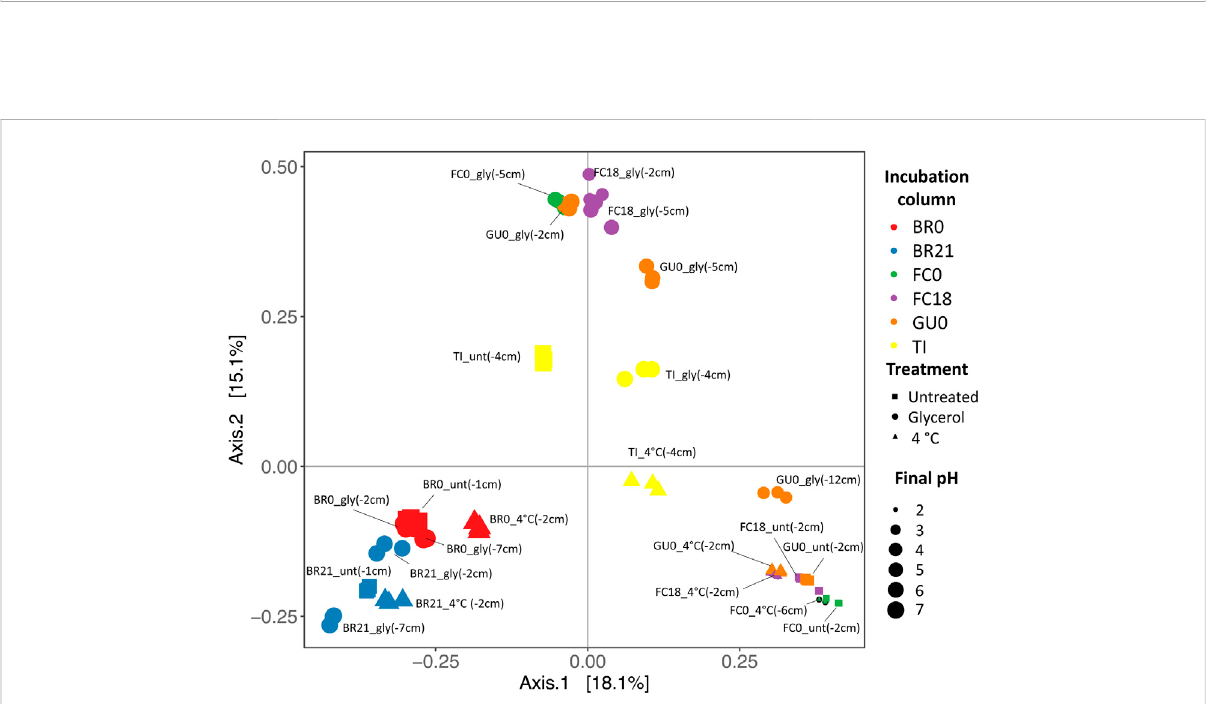
FIGURE 9 Principal Coordinates Analysis (PCoA) based on the Bray Curtis dissimilarity between samples. Per set of triplicates, the site, treatment and sampling depth (cm) are displayed. Treatment is re fl ected as gly (glycerol-amended, circles), unt (untreated, squares), 4 ° C (cool-stored, triangles). Colors represent the original site + depth (red: Brunita monimolimnion (BR0), blue: Brunita mixolimnion (BR21), green: Filón Centro mixolimnion; purple:FilónCentro monimolimnion(FC18), orange:Guadianamixolimnion(GU0); yellow: Tintillo stream (TI)).Thesize oftheshapesindicated the fi nal pH (2:7,